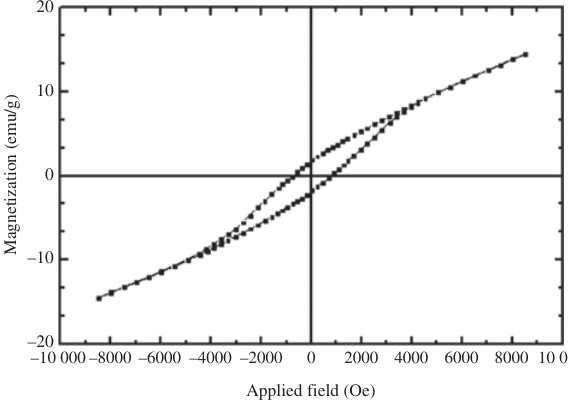
O -TiO nanocomposites 12 19 2